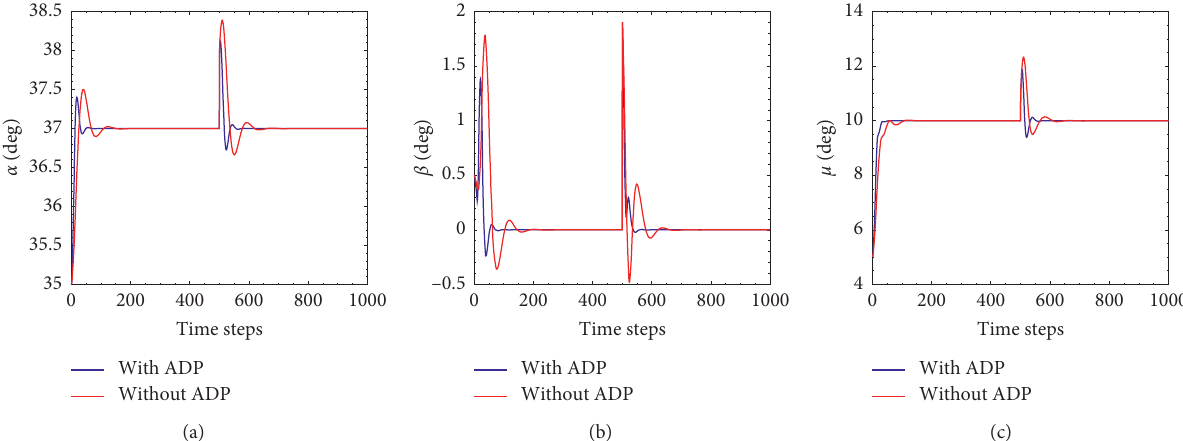
Figure 5: Tracking result of the three attitude angles. (a) The angle of attack α . (b) The sideslip angle β . (c) The bank angle μ